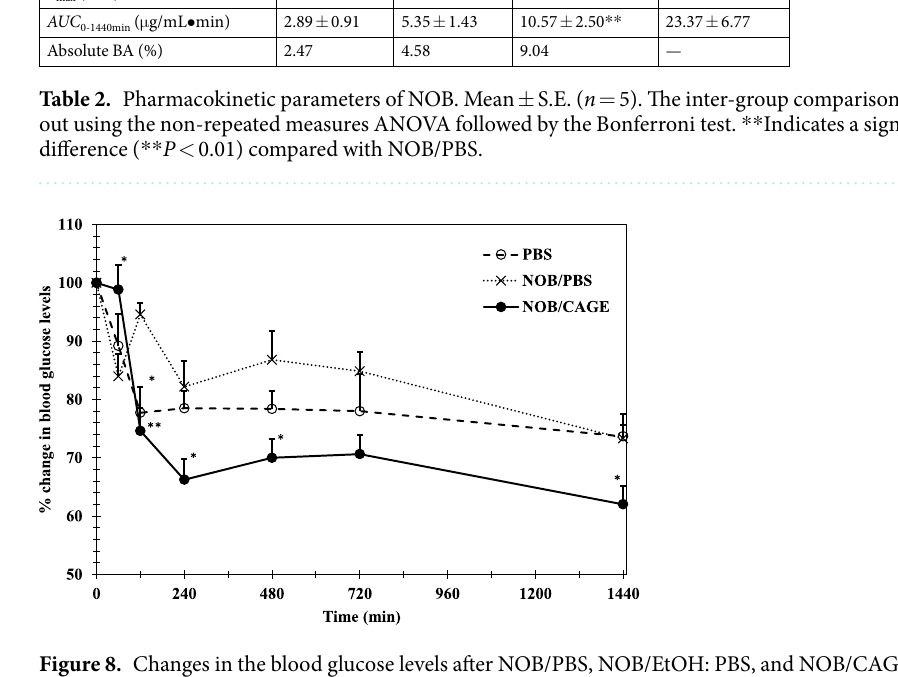
Figure 8. Changes in the blood glucose levels after NOB/PBS, NOB/EtOH: PBS, and NOB/CAGE were transdermally administered. A 5 mg/mL concentration of PBS, NOB/PBS, or NOB/CAGE was transdermally administered (10 mg/kg) to rats and blood was collected from the tail vein up to 24 h. Blood glucose was measured using a commercial glucose meter. Each point represents the mean ± S.D. ( n = 5). Inter-group comparison was carried out by the non-repeated measures ANOVA followed by the SNK test. * and ** represent a significant difference ( * P < 0.05, ** P < 0.01) compared to